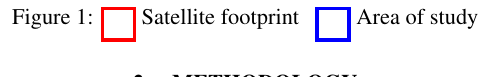
Figure 1: Satellite footprint Area of study Table 2: Pre-processing features and selected